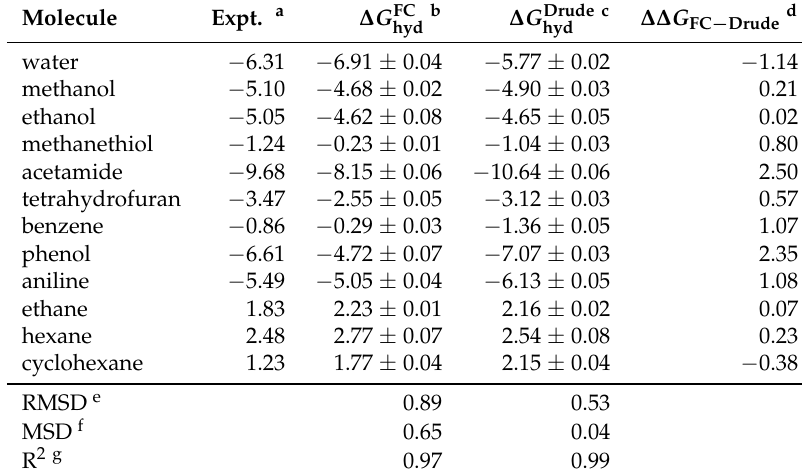
Table 1. Hydration free energies obtained with the CHARMM fixed charge and the CHARMM Drude force field in